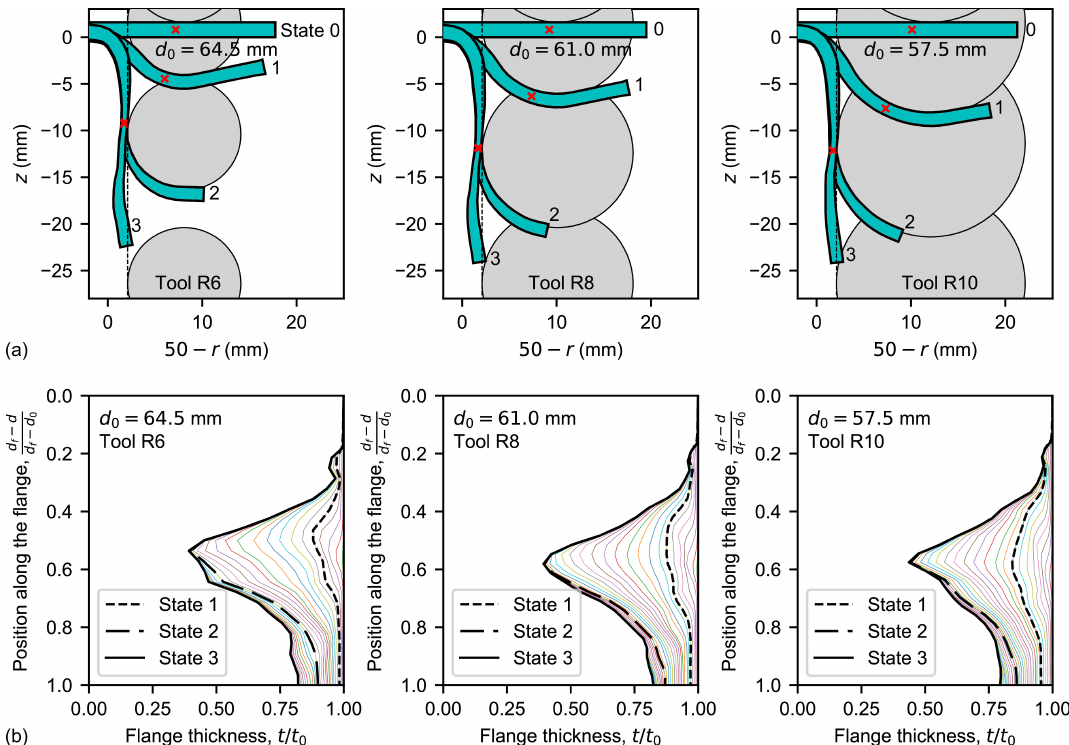
Figure 10. Simulations of hole-flanging processes by single-stage SPIF: ( a ) flange profile and tool position; and ( b ) flange